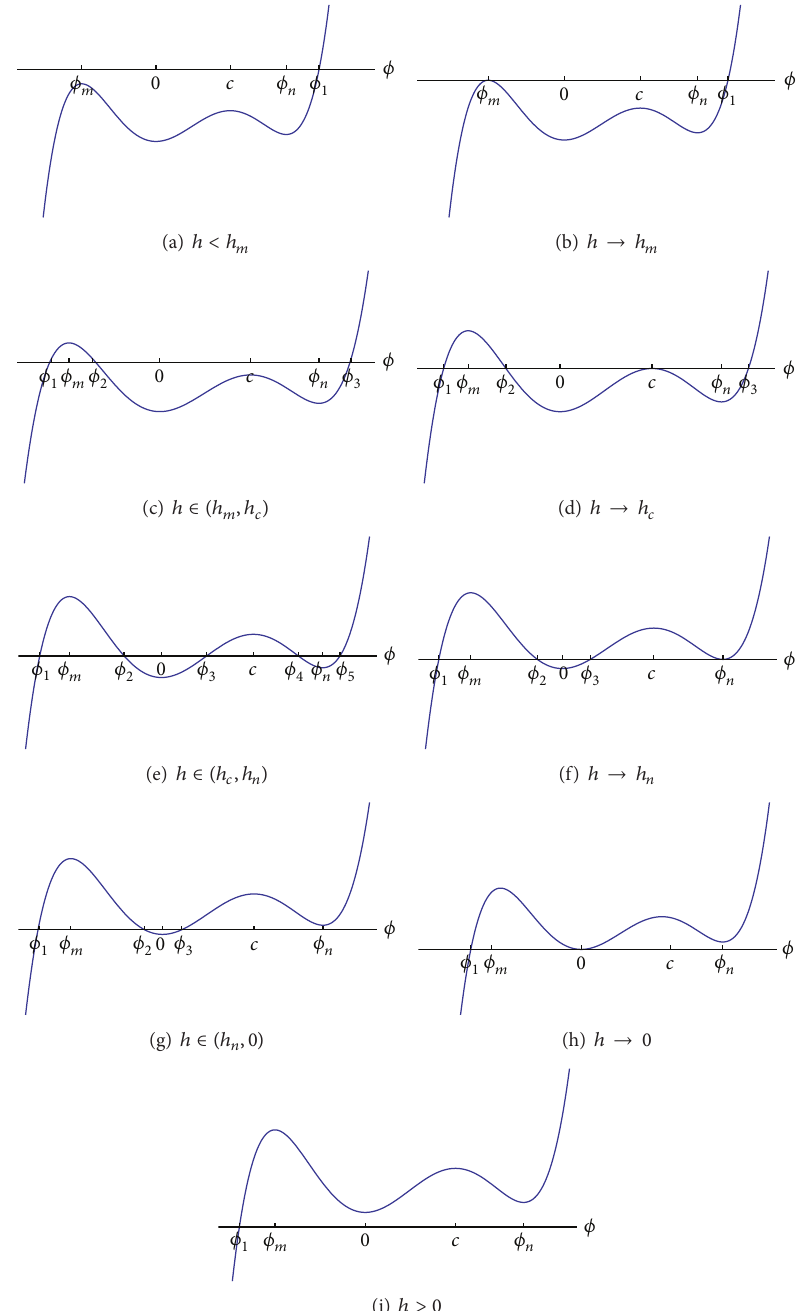
Figure 4: The graph of 𝐹(𝜙) as (1/16)(16𝑐 − 75𝑐 2 ) < 𝑐 0 < (1/3)(3𝑐 − 4𝑐 2 )